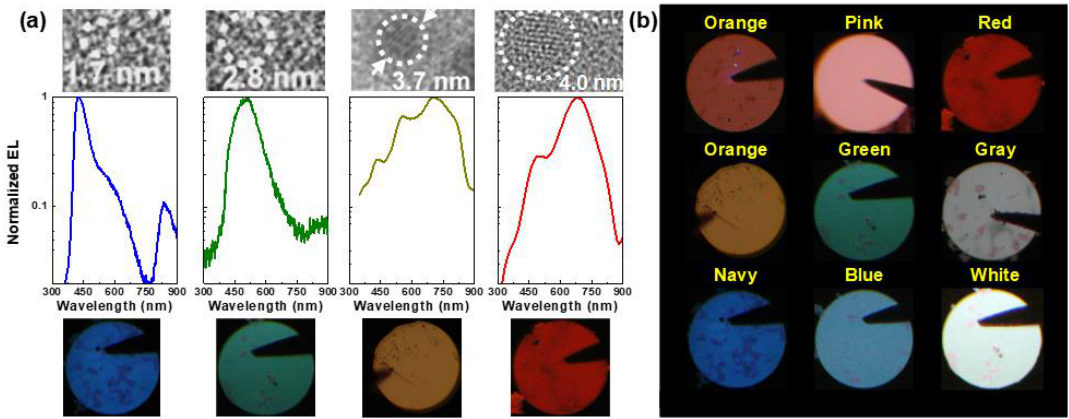
Figure8. ( a )ELspectraofSi-QDmetal-oxide-semiconductorLEDs(MOSLEDs)withtheircorresponding Figure 8. ( a ) EL spectra of Si-QD metal-oxide-semiconductor LEDs (MOSLEDs) with their EL patterns and Si-QD size. ( b ) Versatile EL emission patterns of Si-QD corresponding EL patterns and Si-QD size. ( b ) Versatile EL emission patterns of Si-QD MOSLEDs.